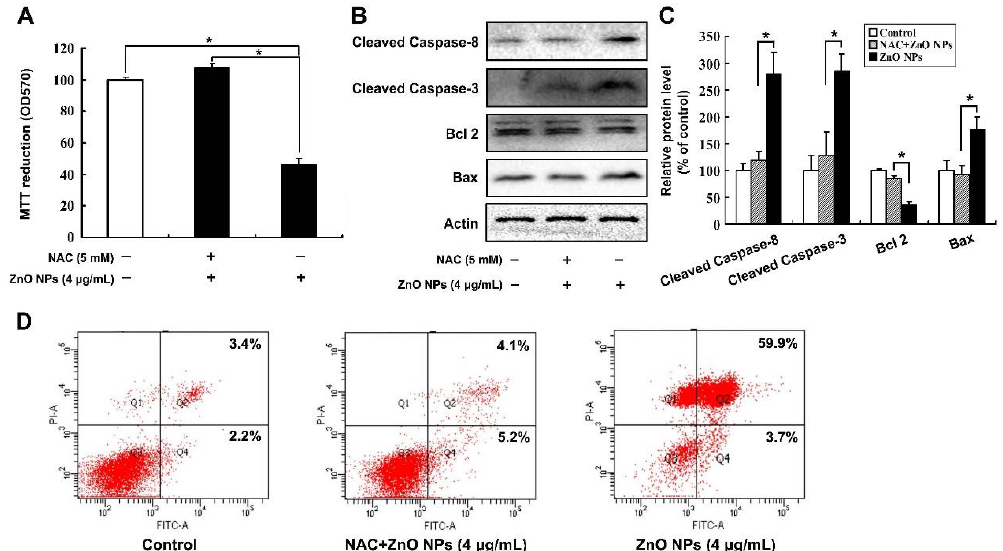
Figure 4. Oxidative stress is involved in ZnO NPs-induced apoptosis of mouse Leydig TM3 cells. Mouse Leydig TM3 cells were treated with 4 µ g / mL ZnO NPs for 24 h in the absence or presence of 5 mM NAC, then cell viability ( A ), the protein levels of cleaved Caspase-8, cleaved Caspase-3, Bcl 2, and Bax ( B ) and the AnnexinV-FITC positive staining cells ( D ) were detected by MTT assay, Western blot, and flow cytometry, respectively. ( C ) The relative protein levels of cleaved Caspase-8, cleaved Caspase-3, Bcl 2, and Bax were quantified by densitometry. The experiment was done in triplicate and repeated three times. Data were analyzed by one-way ANOVA. * p < 0.05.